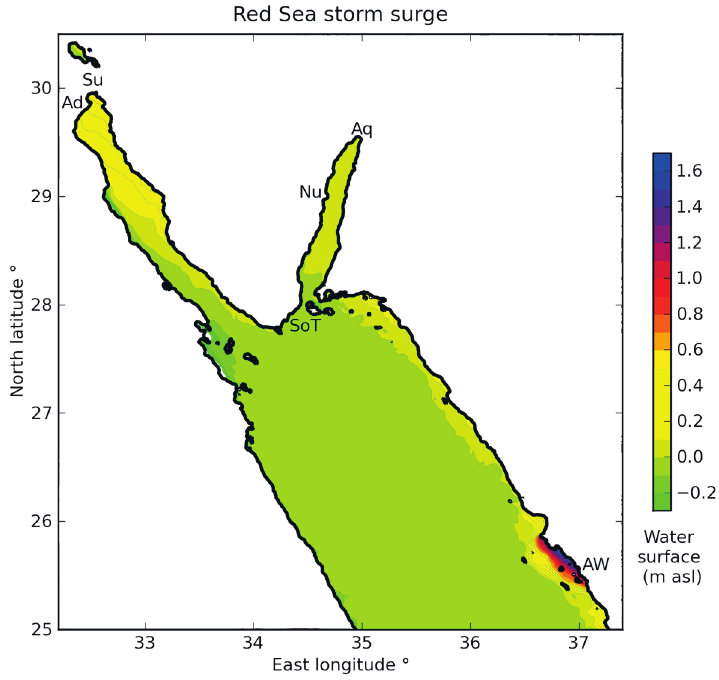
Figure 6. Red Sea surge height with wind from southwest (230° Cartesian). Note the extreme storm surge at